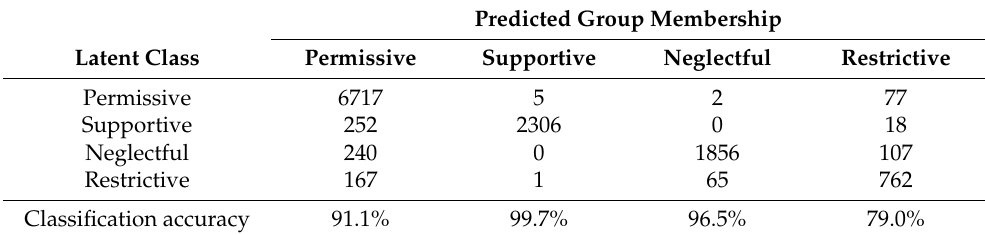
Table 4. Summary of the discriminant analysis classification (four-class